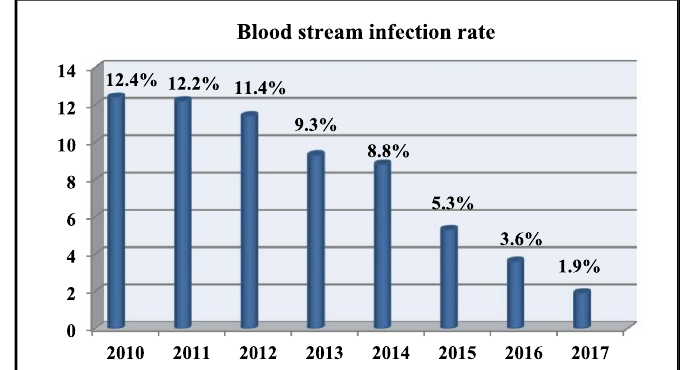
Fig. 4. Observed bloodstream infection rate in the hospital